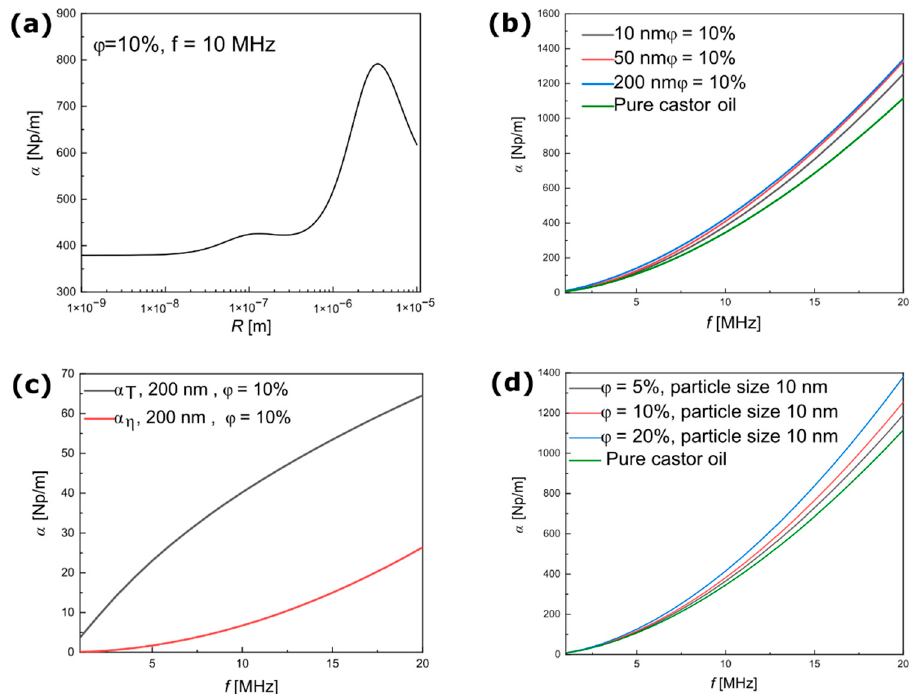
Figure 4. Theoretical results of ultrasound attenuation in dispersions of magnetite NPs obtained from the ECAH model. ( a ) Ultrasound attenuation versus particle radius at a constant frequency of 10 MHz. ( b ) Ultrasound attenuation coefficient versus frequency for different particle sizes. ( c ) Contribution of thermal and viscous loss to the ultrasound attenuation coefficient without the influence of background attenuation. ( d ) Ultrasound attenuation coefficient versus frequency for different concentrations of magnetite NPs. The attenuation spectra for pure castor oil were obtained from [32] .